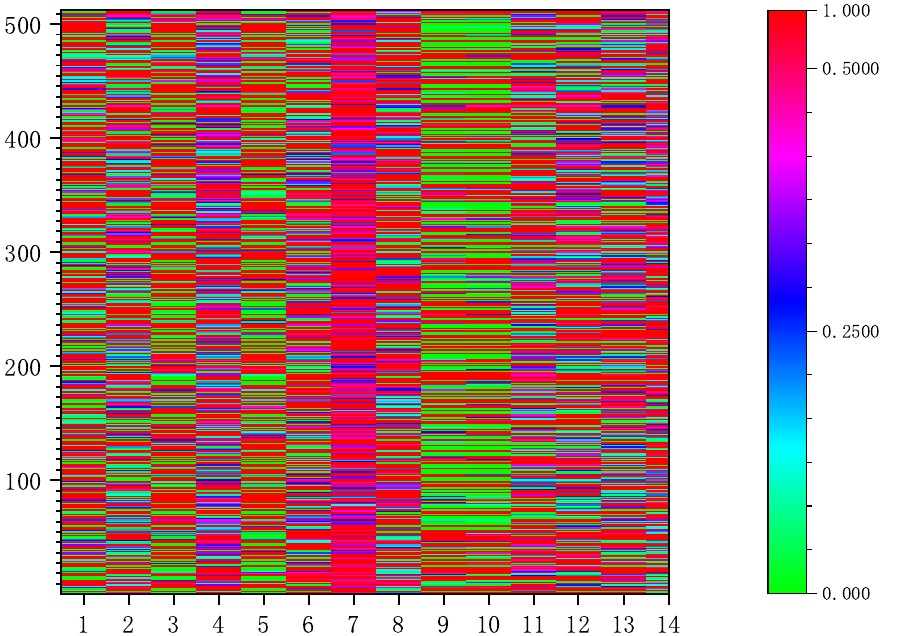
Figure 3. The visualization result of the output value of the identity weight generation